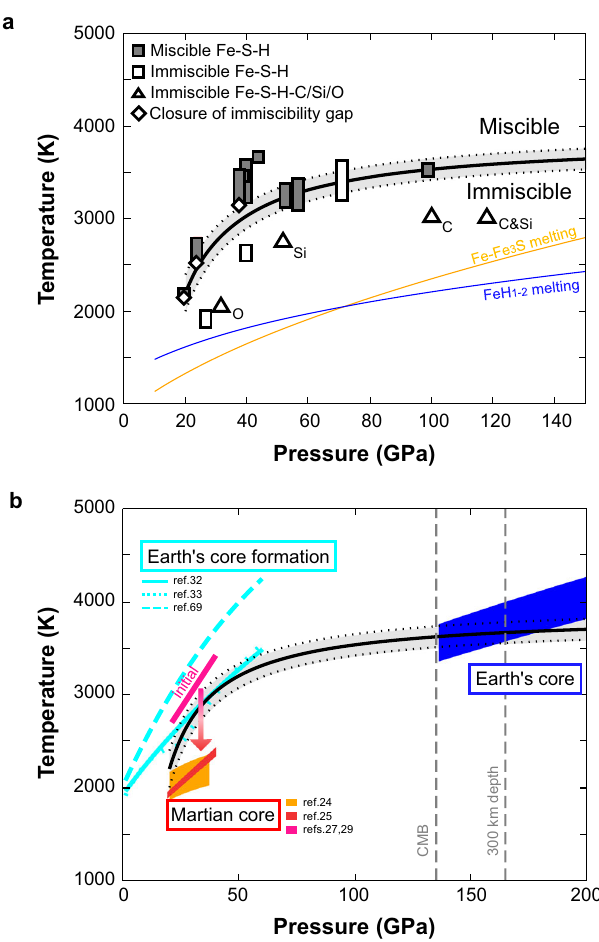
Fig. 2 Pressure( P )-temperature( T ) conditions for immiscibility in liquid Fe-S-H. a Experimental results showing a homogeneous single liquid ( fi lled) and two immiscible liquids (open) in Fe-S-H (rectangles) and Fe-S-H-C/Si/ O (triangles). Elements other than Fe, S, and H are indicated. Miscible/ immiscible boundary (black line) and its uncertainty band (dashed lines) are based on the P - T conditions of miscible/immiscible border in a sample (diamonds) (runs #1, 2, and 4) and those of miscible/immiscible liquids obtained near the boundary. Yellow and blue lines are melting curves in the Fe – Fe 3 S 55 and Fe – FeH x ( x > 1) systems 57 , respectively. b Blue band indicates the isentropic temperature pro fi le of the Earth ’ s core with the core-mantle boundary temperature T CMB = 3600 K 68 . Light-blue lines are the P - T paths for segregation of core-forming metals from silicate 32,33,69 . Temperature pro fi les of the initial 27,29 (pink) and present-day Martian core (orange 24 and red 25 ) are also